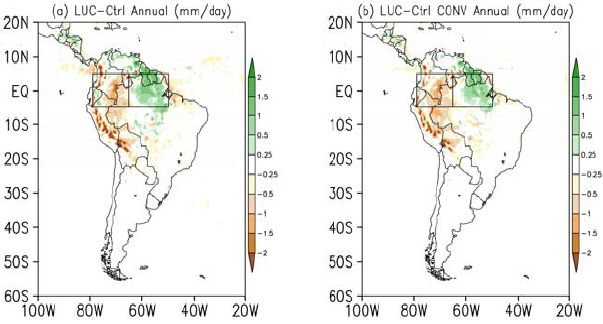
Figure 5. Precipitation change (LUC minus CTRL simulation) in mm day − 1 for ( a ) total precipitation and ( b ) convective precipitation. Rectangles indicate the western (left) and eastern (right) sides of Amazon.